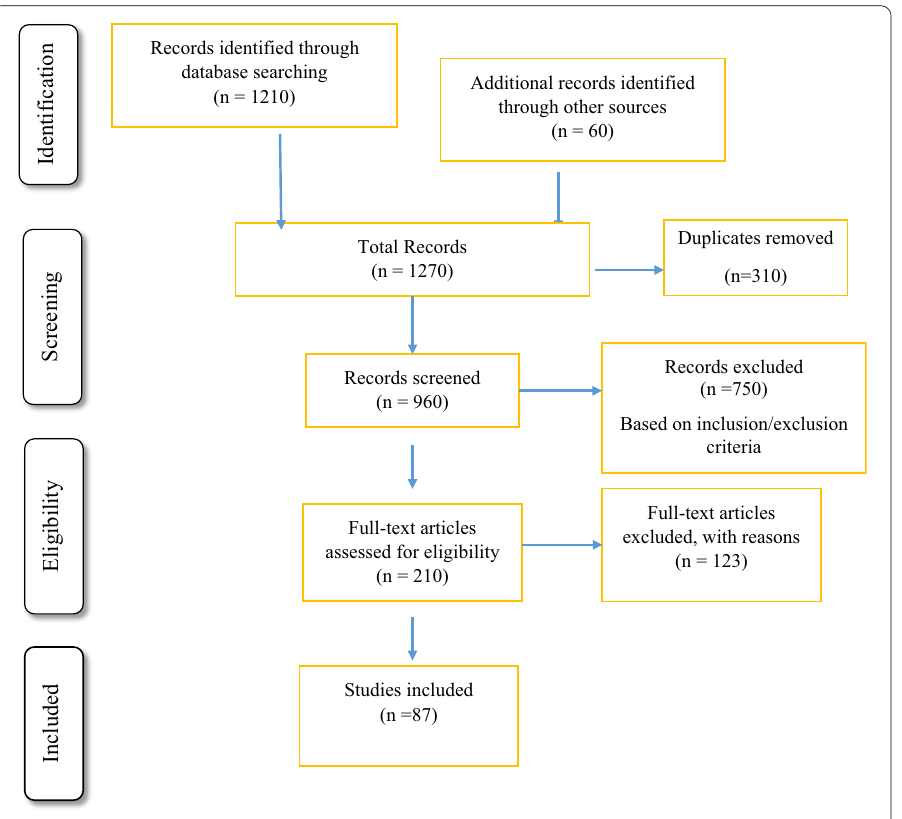
Fig. 1 Study selection process (PISMA flow